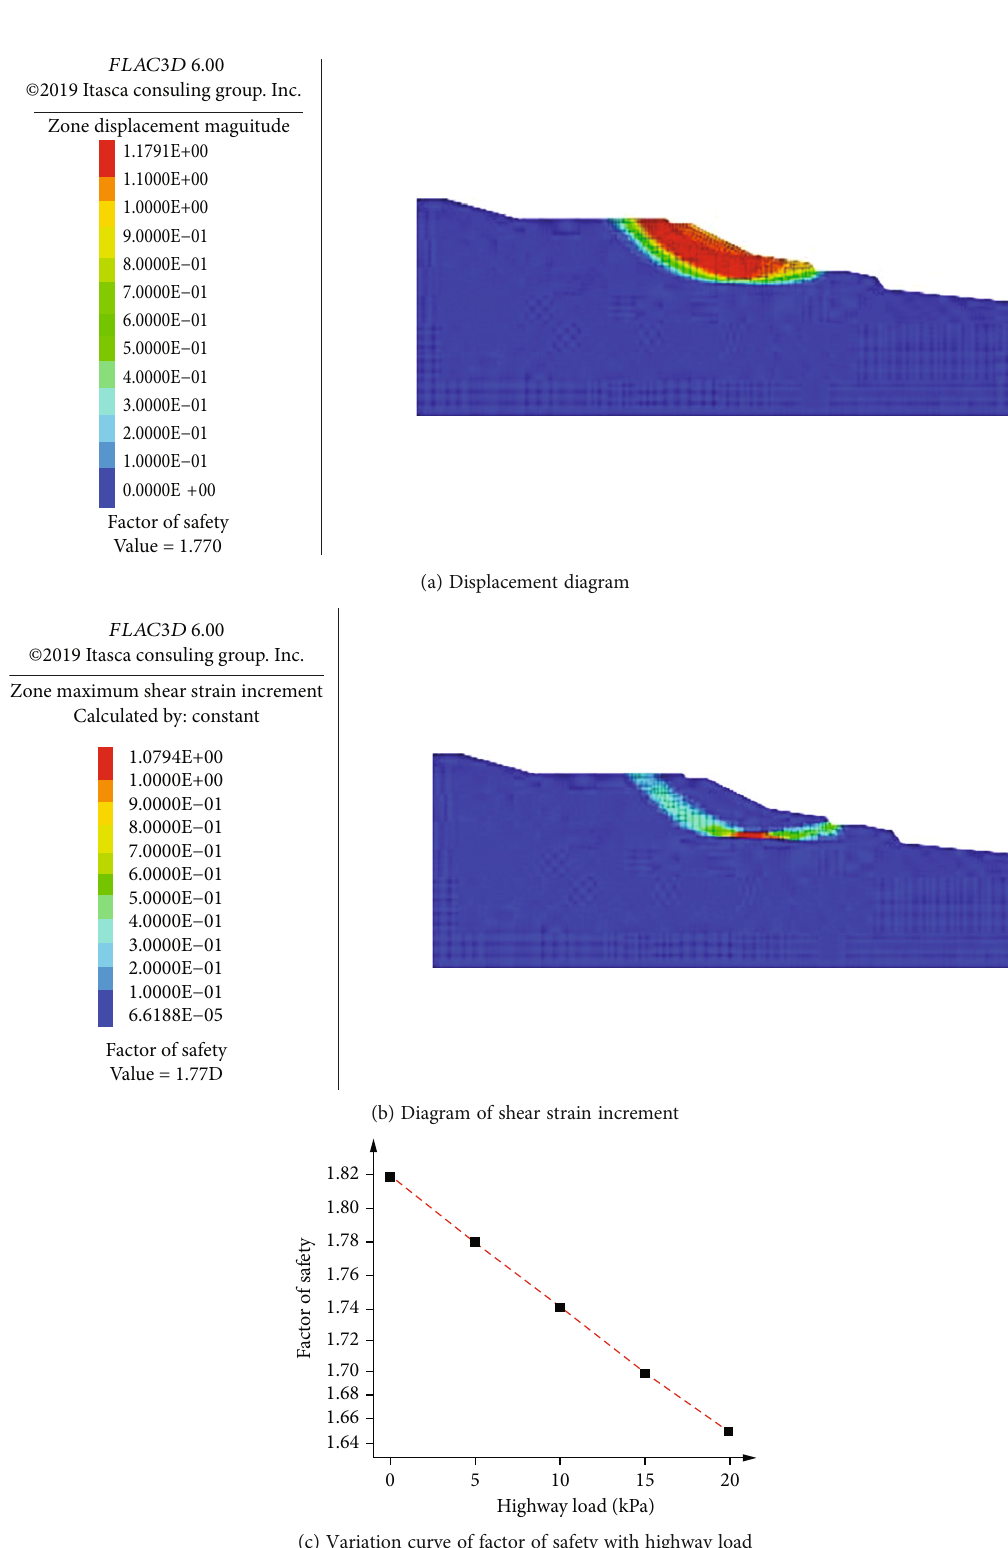
(c) Variation curve of factor of safety with highway load Figure 18: E ff ect of highway load on slope